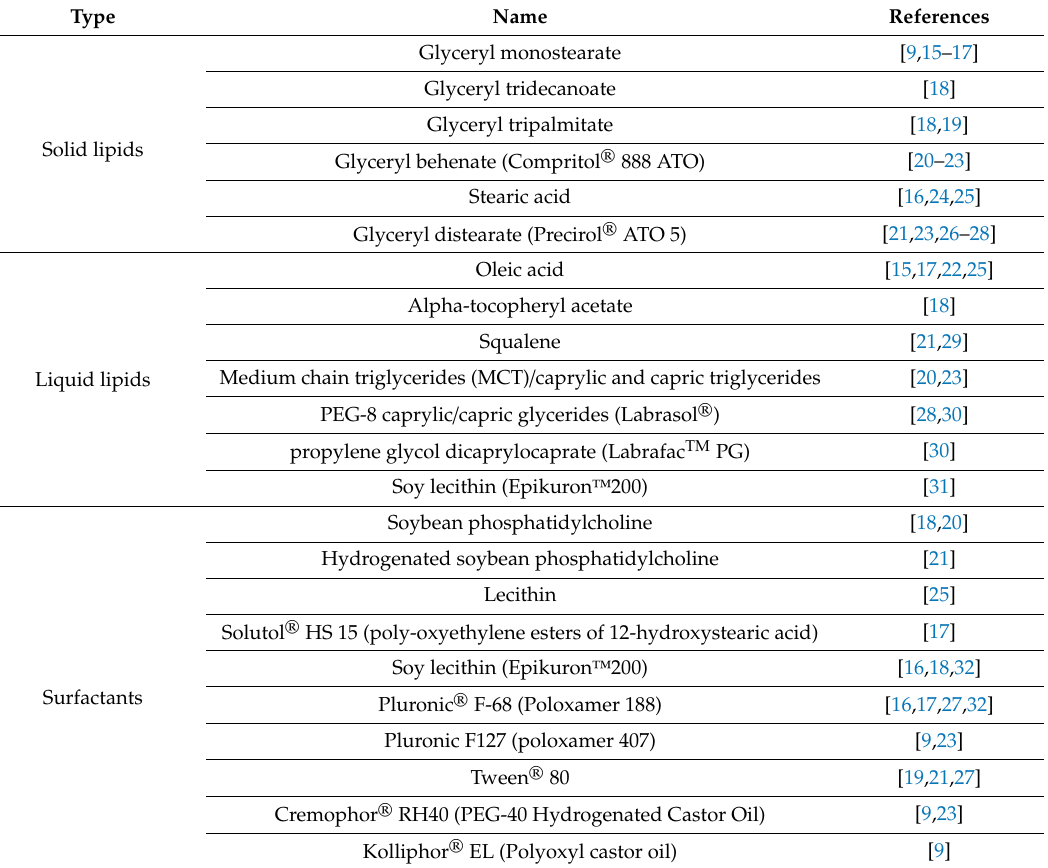
Table 1. Ingredients used in formulation of